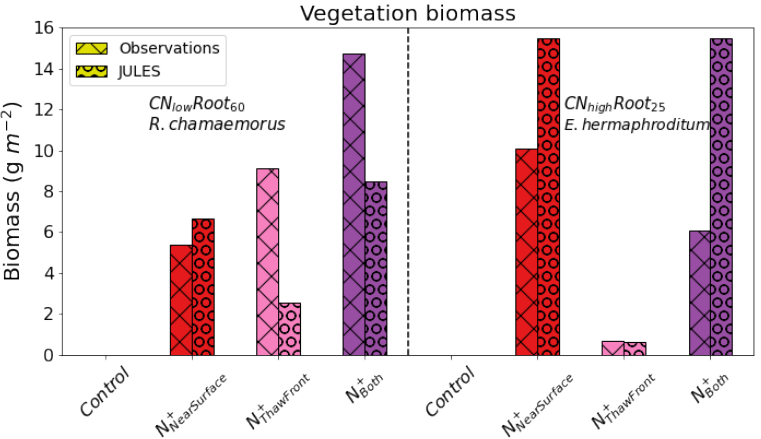
Figure 6. The increase in vegetation aboveground biomass for the N addition experiments compared to the vegetation aboveground biomass of the Control for June 2011. JULES output is the right-hand bar of the pairs and the observations are the left-hand bar. The different colours of the bars represent is purple. is pink, and N + is red, N + the different addition experiments: N + Both ThawFront NearSurface